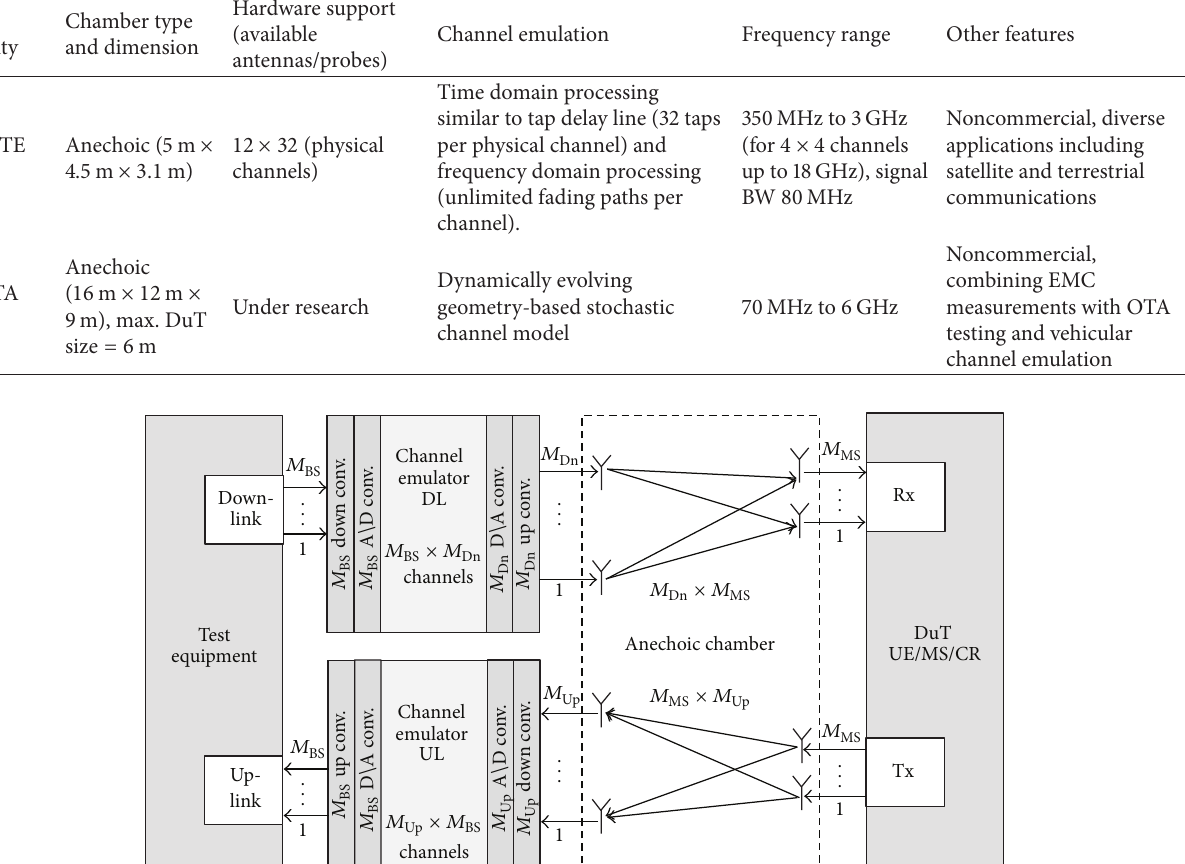
Table 2: Summary of the OTA test facilities in Ilmenau.